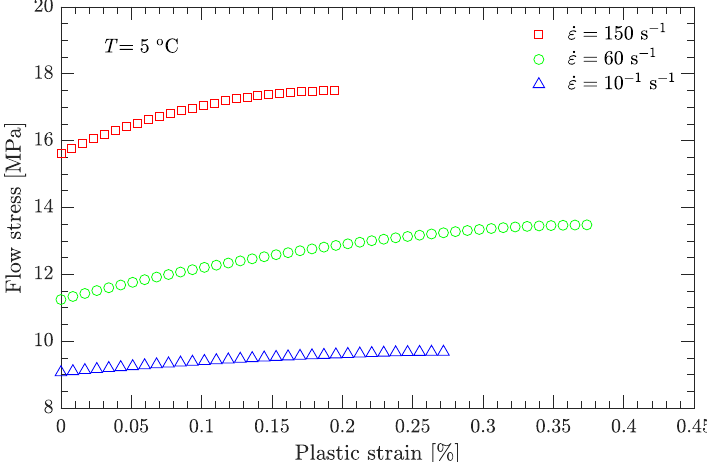
Figure 5. Measured flow stress vs. plastic strain at a temperature of 5 ◦ C.